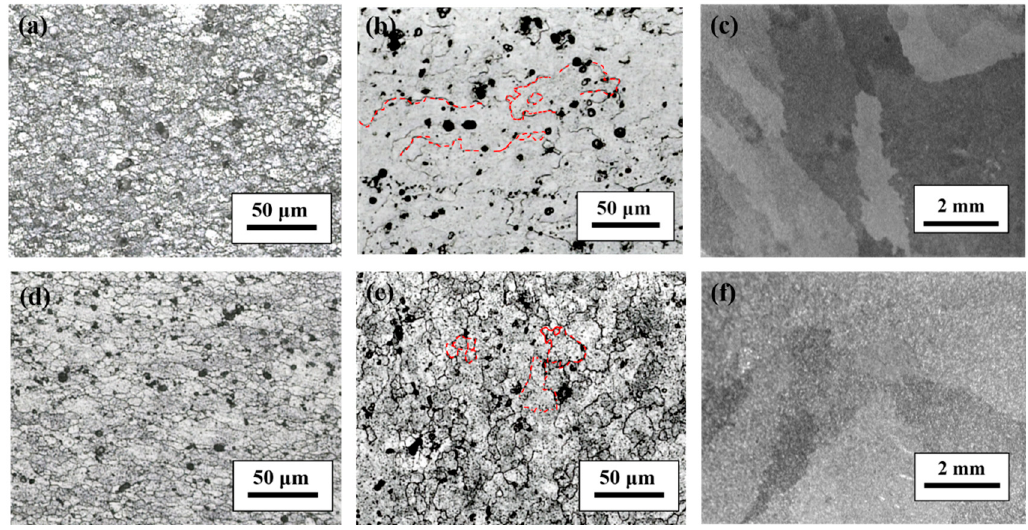
Figure 5. Microstructural features of ( a ) RH10; ( b ) RH30; ( c ) RH120; ( d ) IR10; ( e ) IR30; and ( f ) IR120.